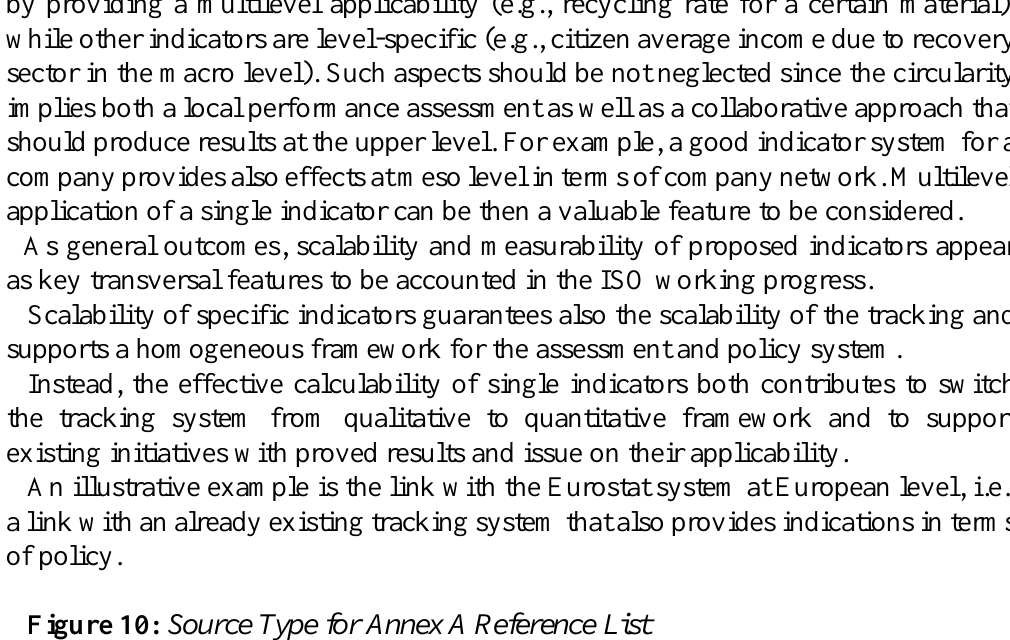
Figure 10: Source Type for Annex A Reference